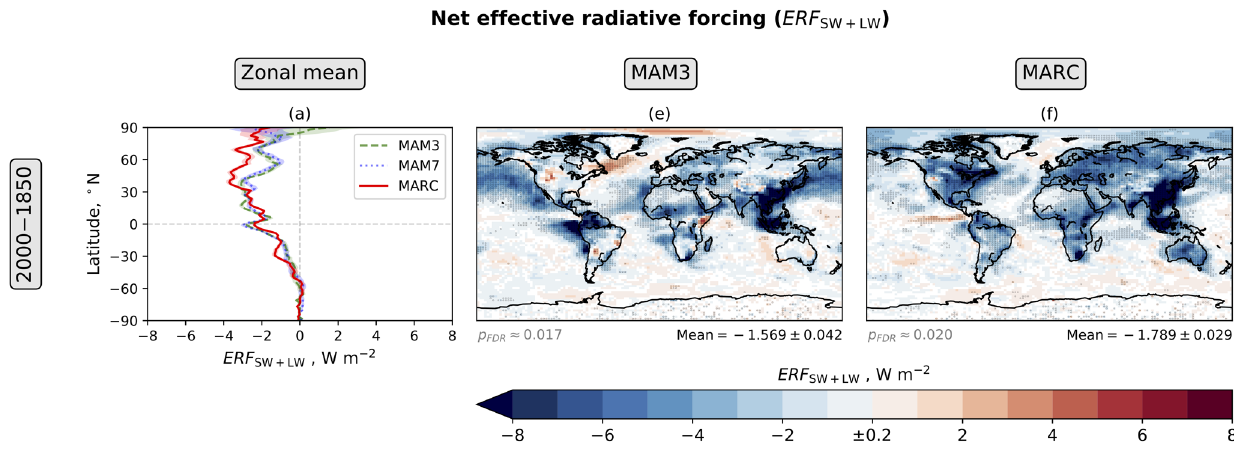
Figure 17. Annual mean 2000–1850 net effective radiative forcing (ERF SW + LW ; Eq. 7). The figure components are explained in the Fig. 2 caption. When comparing the relative contributions of the different radiative effect components to ERF SW + LW , note that different colour bars are used in Figs. 8, 14, 15, and